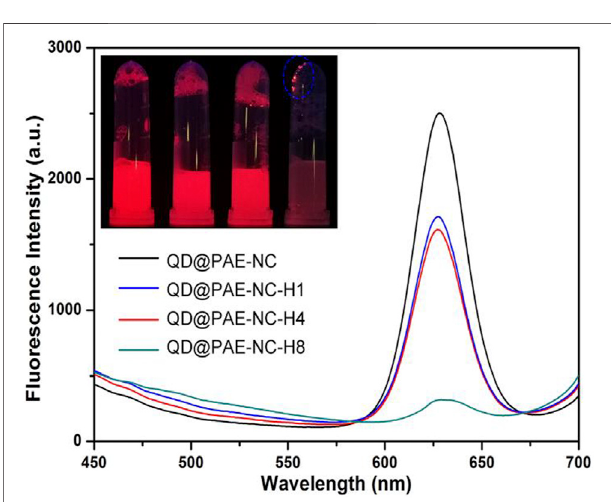
FIGURE6| The fl uorescent emission spectra fromthe aqueous solution containing various QD@PAE-NC composite microparticles; inset image was the samples photo under UV